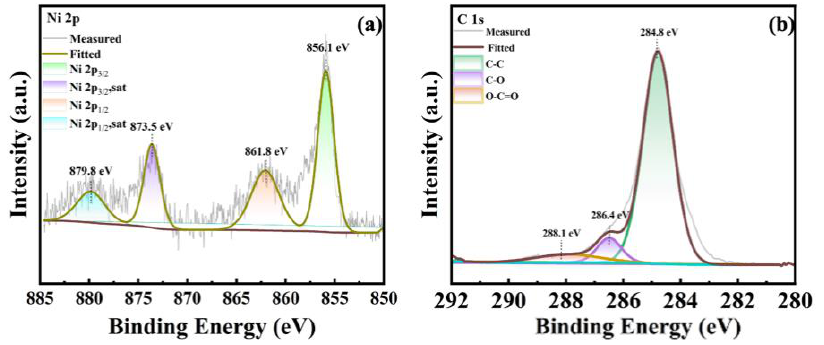
Figure 6. XPS spectra of Ni 2p ( a ) and C 1s ( b ) binding energies on the film PDDA/[Ni25/(PDDA − rGO)] 6 /ITO.